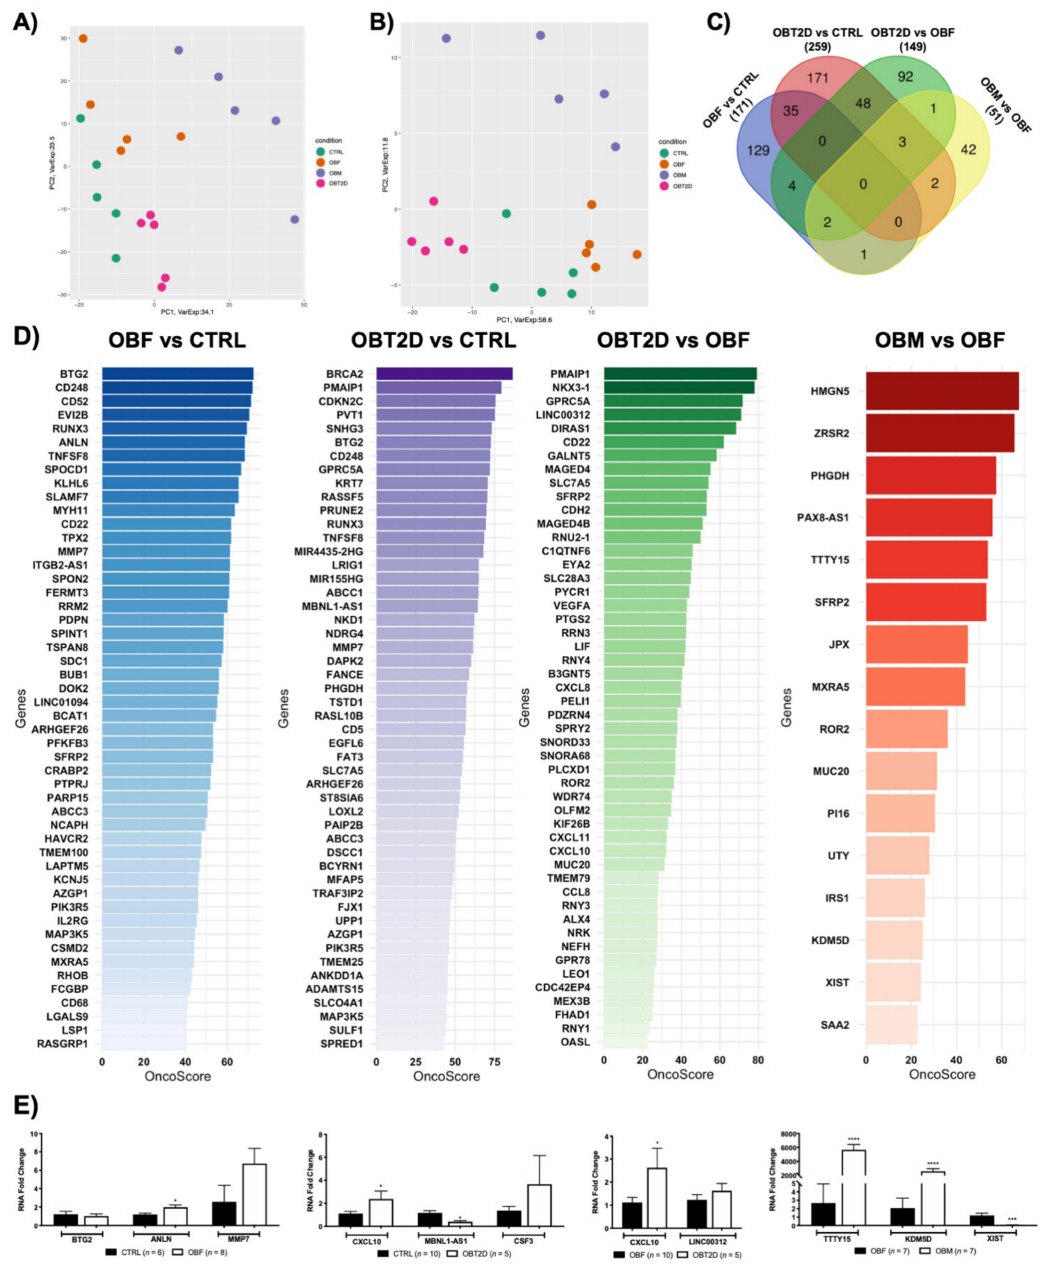
Figure 1. Transcriptome analysis highlights different expression profiles in SAT (Subcutaneous Adipose Tissue) of obese patients. Samples from 5 healthy, normal-weight women (CTRL), 5 obese women (OBF), 5 obese women with T2D (OBT2D) and 5 obese men (OBM) were obtained and four conditions (OBF vs. CTRL, OBT2D vs. CTRL, OBT2D vs. OBF and OBF vs. OBM) were analyzed. ( A ) Principal Component Analysis (PCA) of differentially expressed genes (DE RNAs) in the four conditions. ( B ) PCA of non-coding DE RNAs. ( C ) 171 DE RNAs were identified for OBF vs. CTRL, 259 DE RNAs were identified for OBT2D vs. CTRL, 149 DE RNAs were identified for OBT2D vs. OBF and 51 DE RNAs were identified for OBF vs. OBM. The Venn diagram displays how many genes are shared amongst conditions (http://bioinformatics.psb.ugent.be/webtools/Venn/, last accessed on 15 February 2021). ( D ) The OncoScore library was used to detect which genes, amongst the DE RNAs for each condition, were correlated with cancer. The y-axis represents the name of the DE RNAs related to cancer, the x-axis represents the OncoScore, and the color fades as the genes decrease in ranking. ( E ) mRNA expression levels were evaluated by Real-Time PCR in the different datasets for CTRL vs. OBF, CTRL vs. OBT2D, OBF vs. OBT2D and OBF vs. OBM. Data are expressed as mean ± SEM. The number of patients analyzed for each condition is reported in the figure. * p <0.05, **** p <0.0001 vs. the respective control